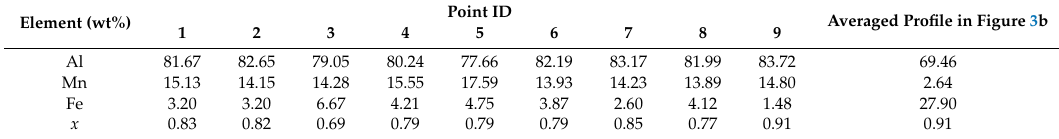
Table 2. EDS point and linescan data from Figure 3b. x denotes the site fraction of Mn in Al 6 (Mn x ,Fe 1 − x )